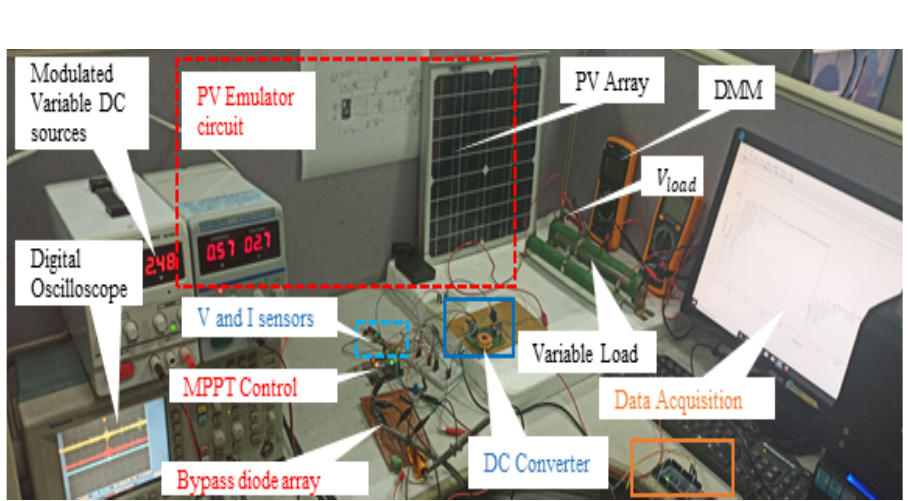
Figure 19. An experimental setup with a low ‐ cost PV emulator.